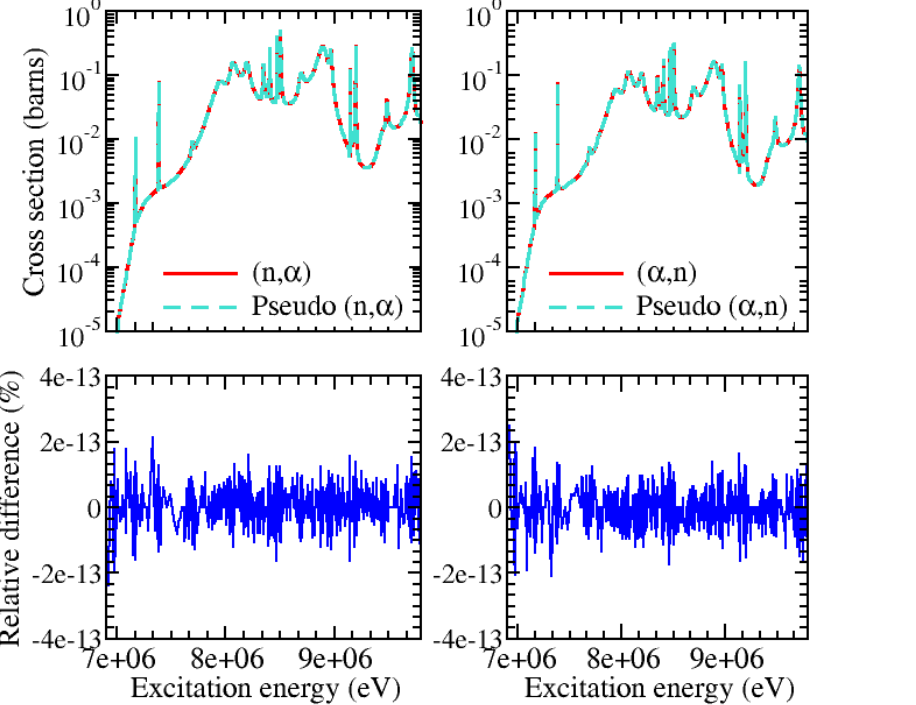
Fig.3. Comparison of the 16 O(n, α ) 13 C and 13 C( α ,n) 16 O cross sections obtained using direct kinematics calculation with the data obtained from the inversion of their reciprocal reaction cross sections labelled as pseudo data. The computation is performed using TORA. Relative differences in percentage are computed as the ratio [(Pseudo data – Direct kinematics calculated data)/Pseudo